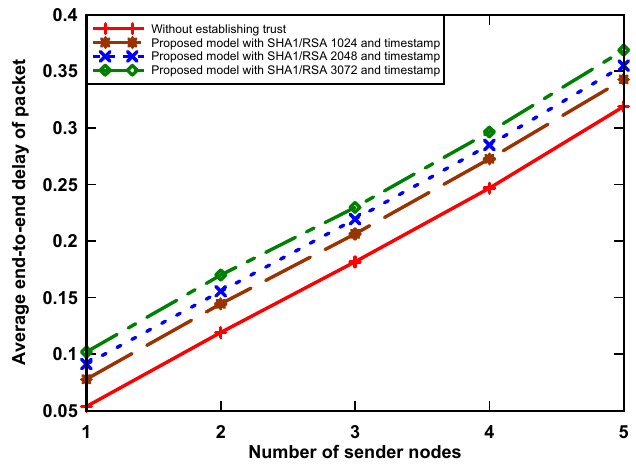
Figure 6. Average packet delay.